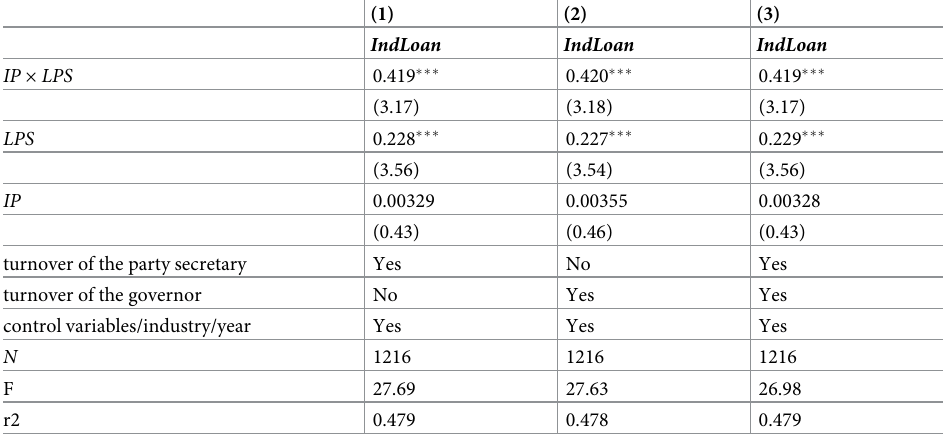
Table 7. Large private shareholders, local industrial policies and industrial loans of city commercial banks (con- sider the turnover of local officials).